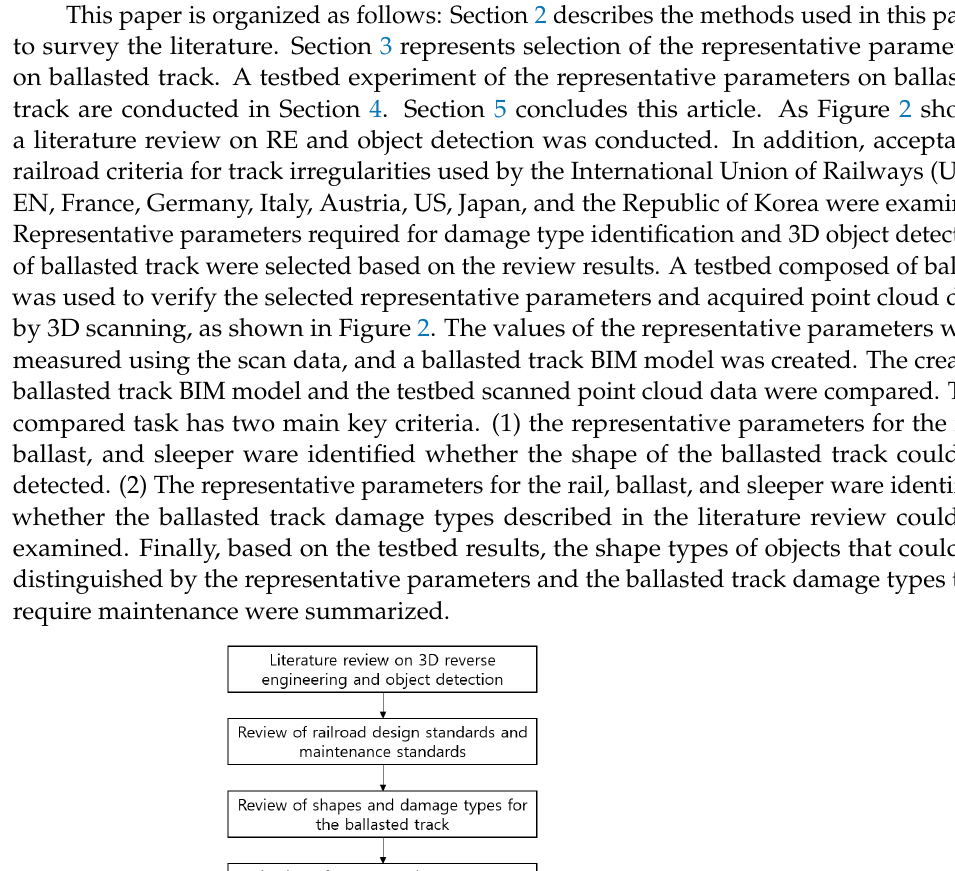
Figure 1. Object detection-based Scan-to-BIM process and research scope.